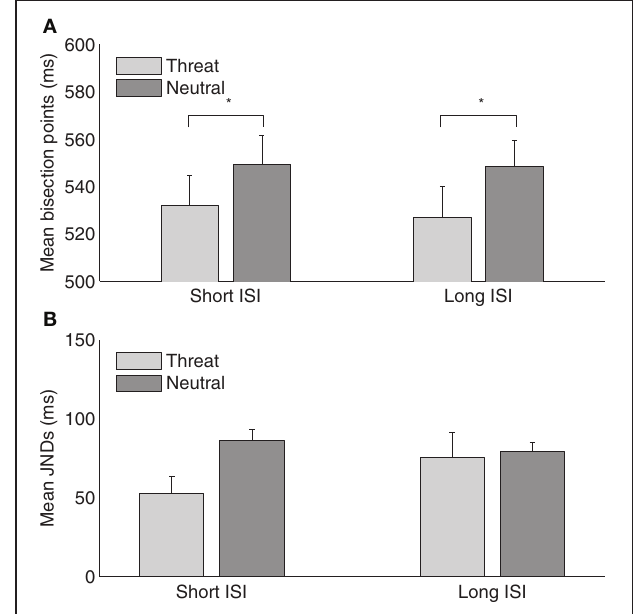
FIGURE 4 | (A) Mean temporal bisection points and (B) mean JNDs (and associated standard errors) plotted against threat and neutral picture conditions, for the short-ISI (500ms) and the long-ISI (1000ms) session ( n = 16).